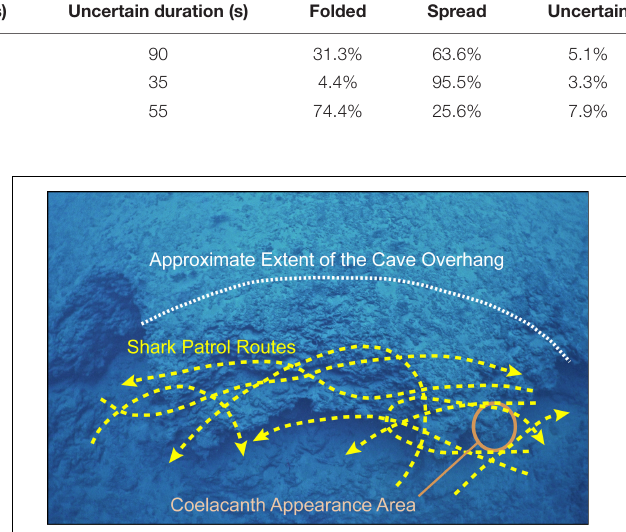
FIGURE 5 | Estimated examples of the paths of the swimming tracks of the shark that repeatedly swam through the cave while the coelacanth was present that are shown superimposed over a photograph looking down at the rock overhang that forms the cave, with the approximate extent of the cave also